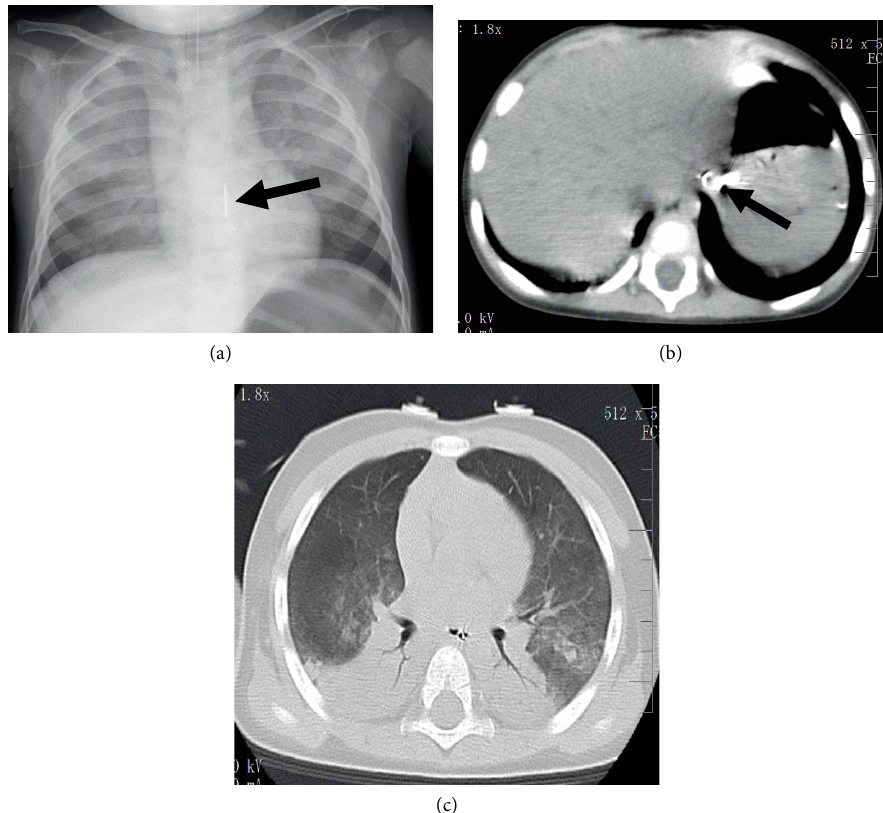
Figure 1: Imaging findings at hospital admission. (a) Chest X-ray; (b, c) chest computed